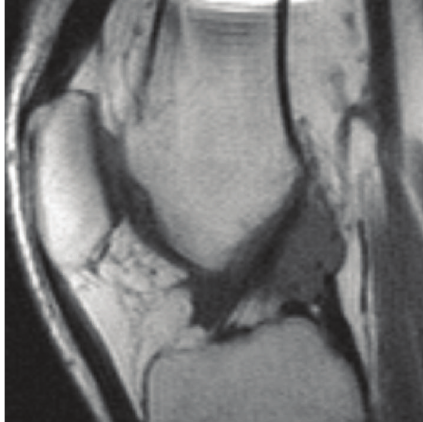
Figure 3: 34-year-old man with a small sarcoma at the cruciate ligaments (case #S6). Sagittal T1-weighted MR image.